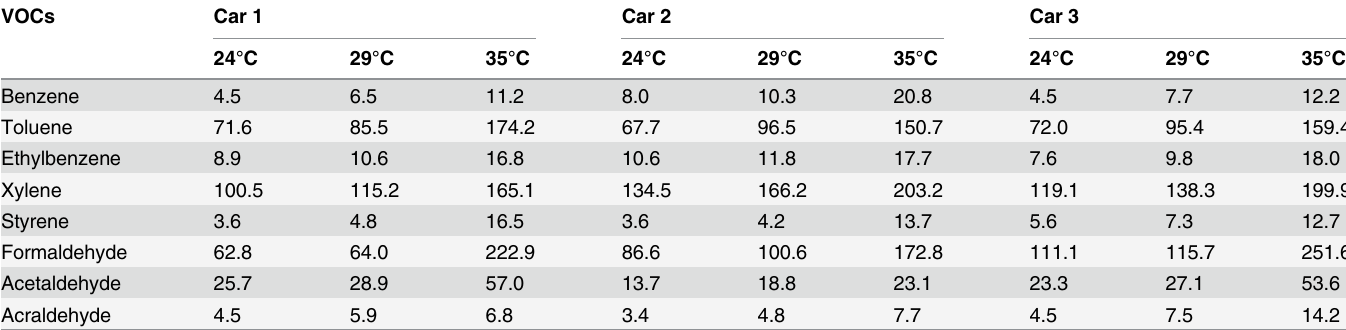
Table 1. The measured concentrations of eight VOCs in the three tested cars at different temperatures (unit: μ g/m 3 ). VOCs Car